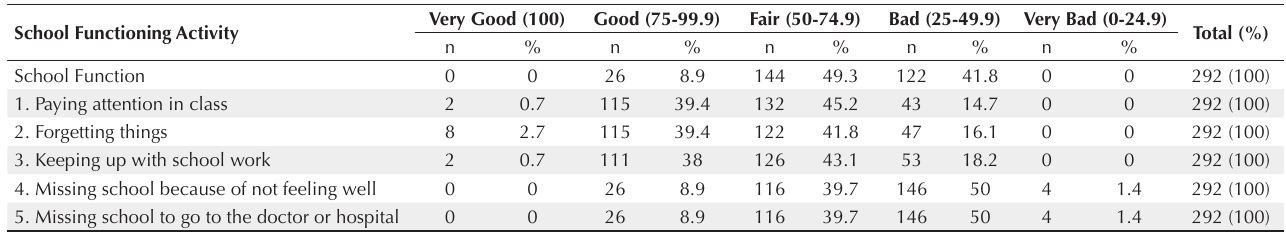
Table 1. Distribution of School Going Thalassemic Children According to School Functioning Activity (n = 292)